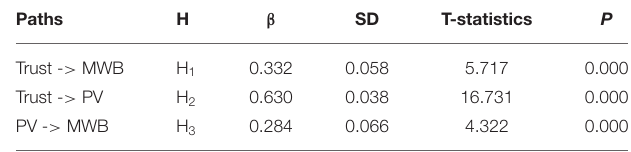
TABLE 5 | Direct effects.